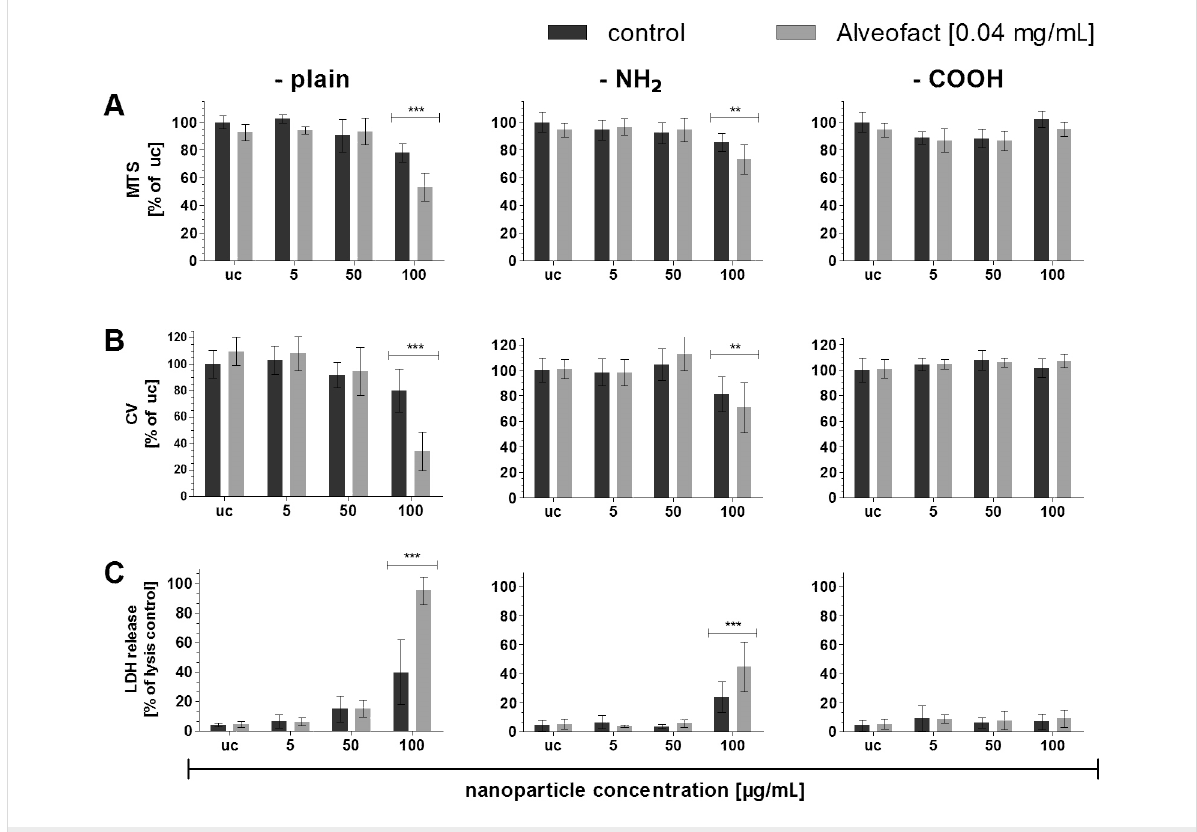
Figure 3: Comparison of cytotoxic effects on A549 after 4 h stimulation with different aSNPs (–plain, –NH 2 , –COOH; 5–100 µg/mL, uc: untreated control) in combination with (light grey columns) and without (dark grey columns) lung surfactant (Alveofact, 0.04 mg/mL). A: Cell viability (mitochon- drial activity, MTS, % of uc); B: cell viability (crystal violet staining of nuclei, cell loss measurement, % of uc); C: LDH release (membrane integrity, % of lysis control). Data are depicted as means ± S.D. of 3 independent experiments with n = 3. For statistical analysis two-way ANOVA with Bonferroni’s post test was conducted. * P < 0.05, ** P < 0.01 and *** P < 0.001 compared to the untreated